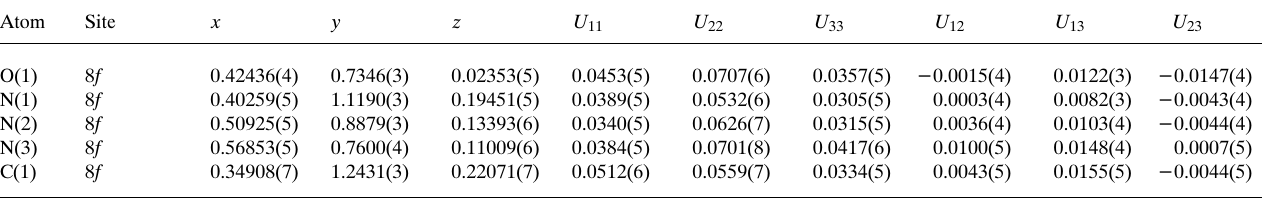
Table 3. Atomic coordinates and displacement parameters (in Å 2 ) .